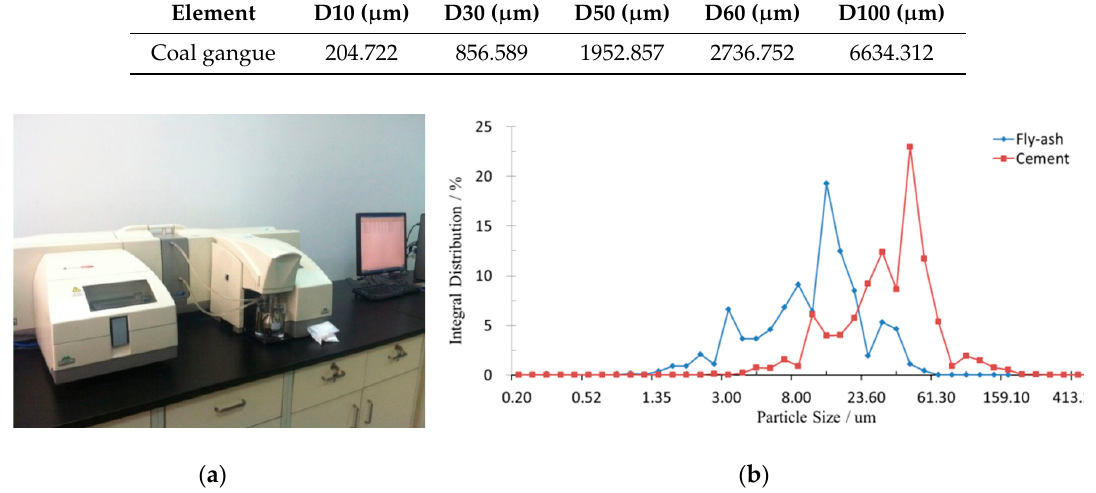
Figure 1. The machine that used in the tests to exam the particle size and particle size distribution of fly ash and cement used in the CGFB sample configuration: ( a ) MALVERN HYDRO 2000MU machine examine the particle size; ( b ) Particle size distribution on the fly ash and cement.